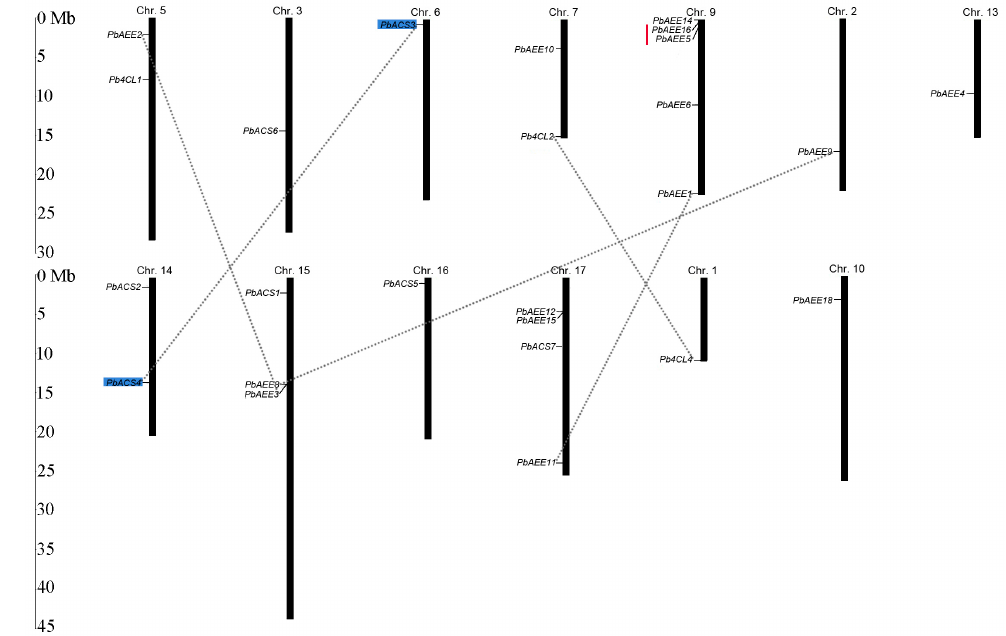
Figure 4. Chromosomal locations and gene duplication of 4CL-related genes in pear. Chromosome numbers are indicated at the top of each vertical black bar, the names on the left side of each chromosome correspond to the approximate locations of each 4CL-related gene. Dashed lines represent segmental duplicated genes, and the tandem duplicated gene pairs are joined by a red line. The scale is in megabases (Mb).